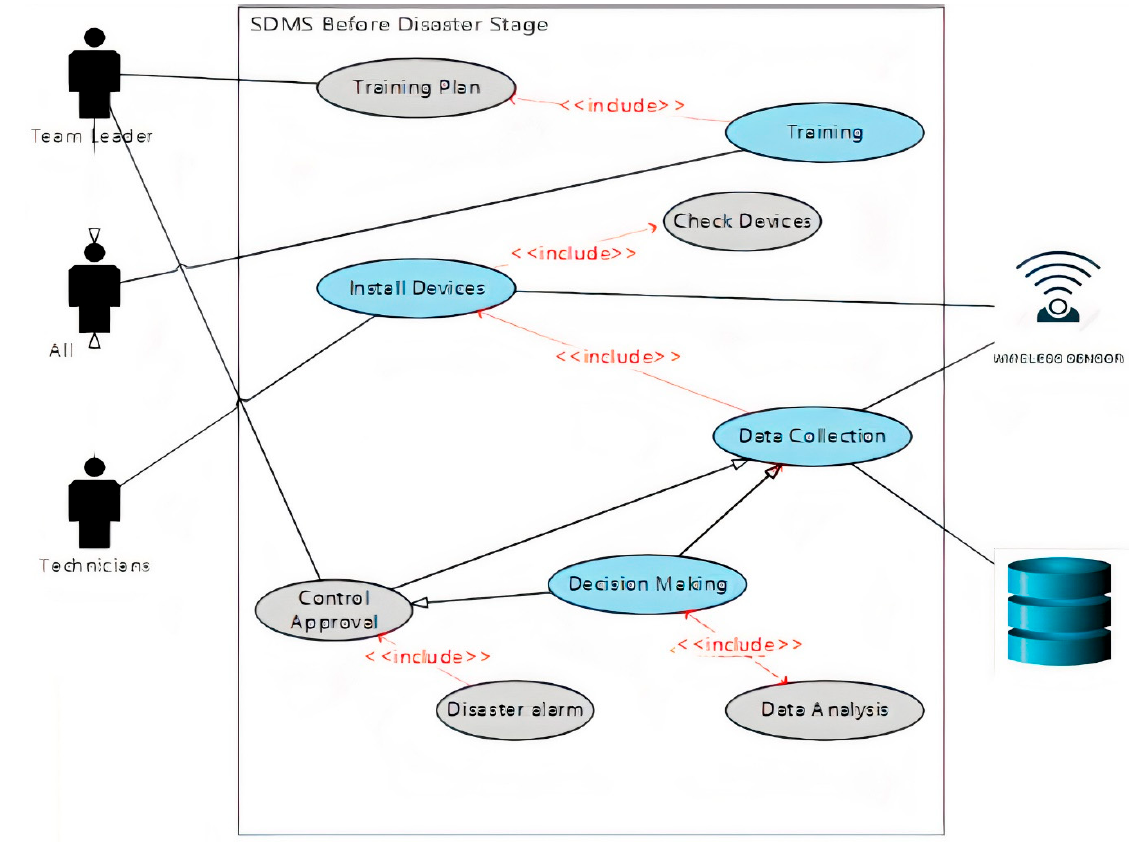
Figure 1 . Use case diagram of before disaster stage [39]. Figure 1. Use case diagram of before disaster stage